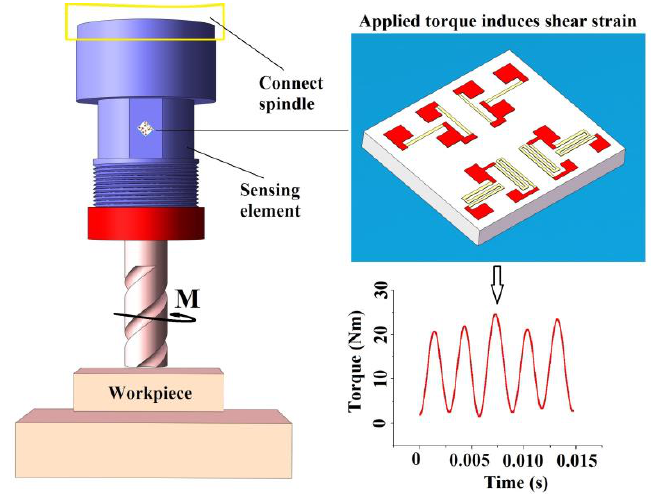
Figure 1. A diagram of the torque sensor using a piezoresistive MEMS strain gauge for measuring torque force. The MEMS strain gauge is 1.8 mm × 1.6 mm × 0.2 mm. The strain gauge detects shear strain with any torque force applied in a milling process.